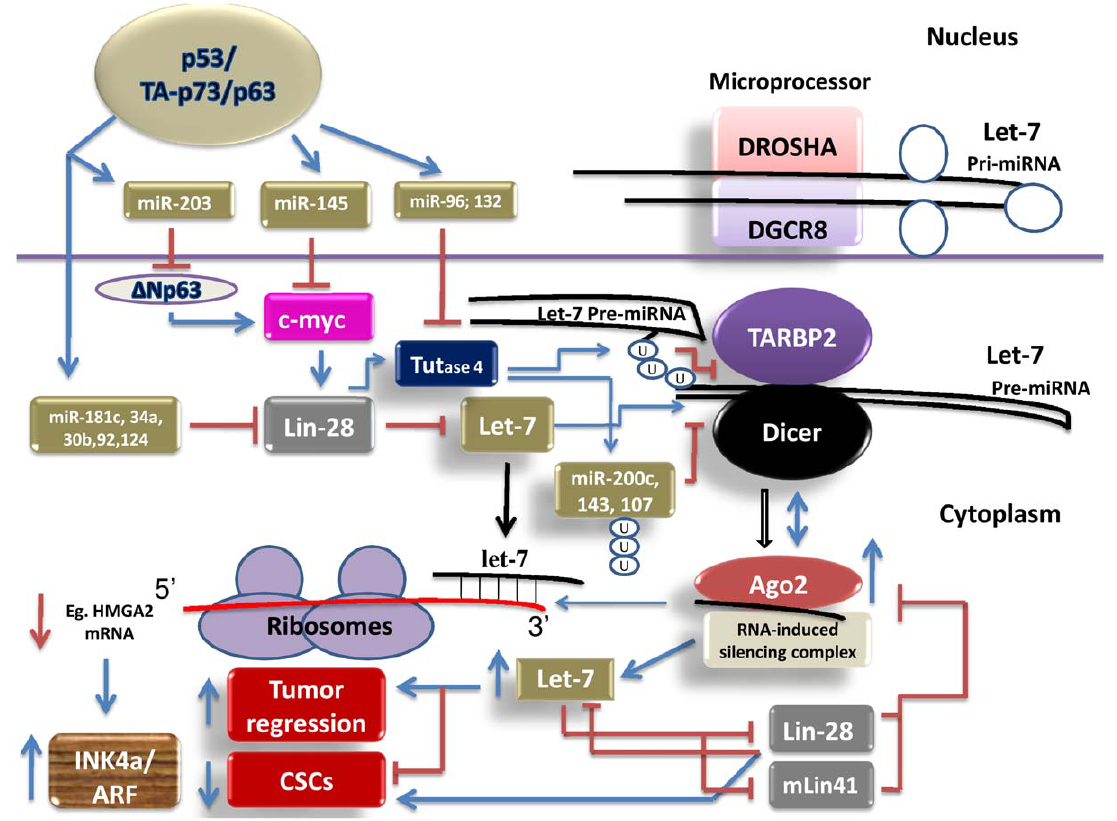
Figure 3. p53, TA-p73/p63, and D Np63 regulate the processing of the tumor suppressor miRNAs, let-7, miR-200, miR-143, and miR-107. doi:10.1371/journal.pone.0010615.g003 PLoS ONE |